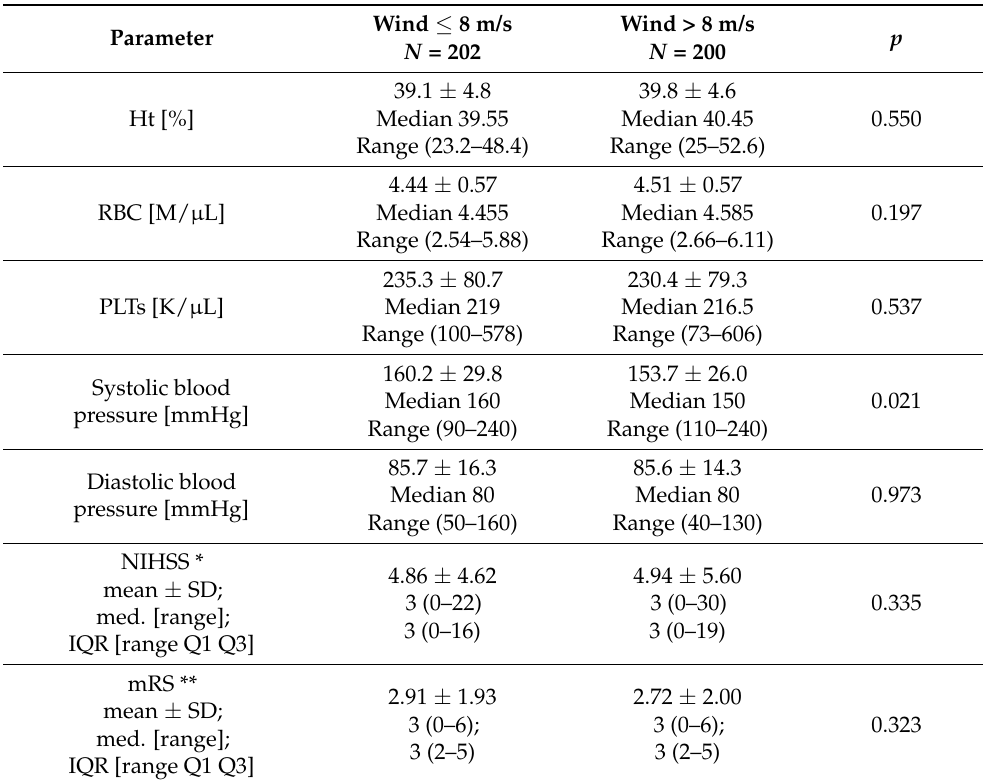
Table 4. Mean values of patients’ selected blood counts, vital signs, neurological and functional state in relation to wind speed on the day of stroke onset.